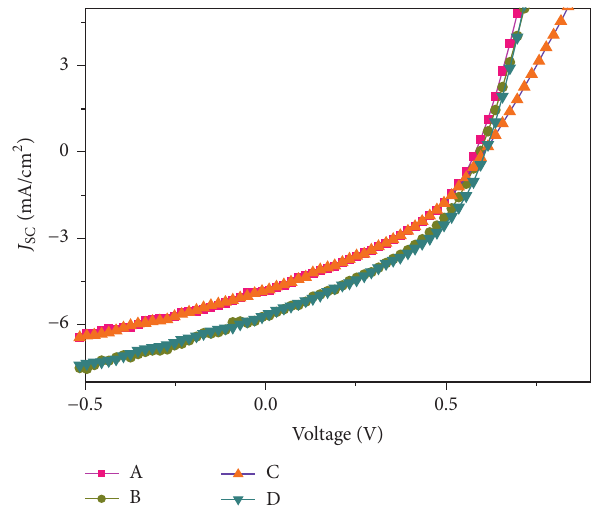
Figure 3: Current density and voltage characteristics of PCPDT- TBTT solar cells: A: without thermal annealing, B: thermal anneal- ingat80 ∘ C,C:thermalannealingat100 ∘ C,andD:thermalannealing at 120 ∘ C.